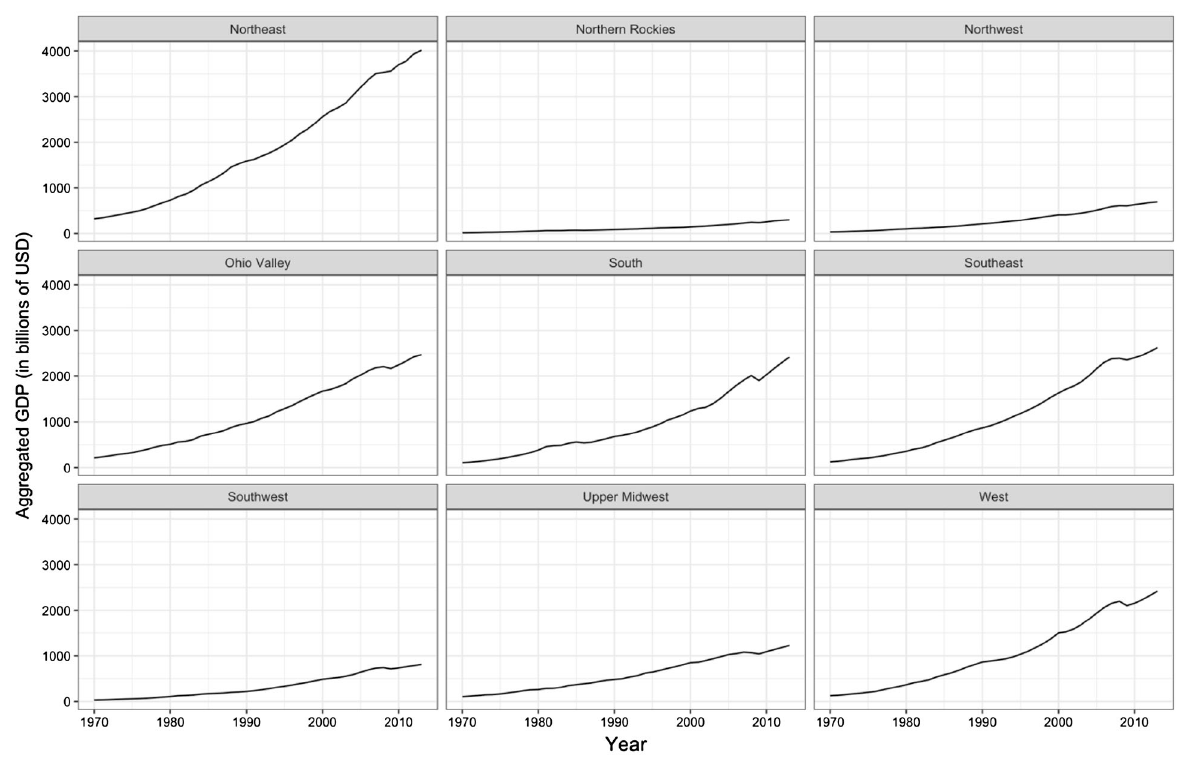
Fig. 3 Aggregated GDP (in billion USD) in the United States by climate region for the period